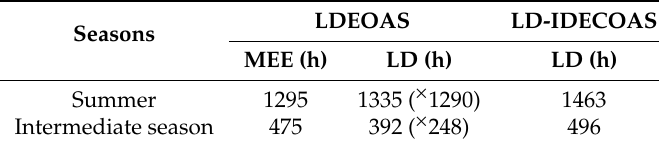
Figure 10. Comparison of seasonal energy consumption. Table 7. Operating time of each component during the two seasons.